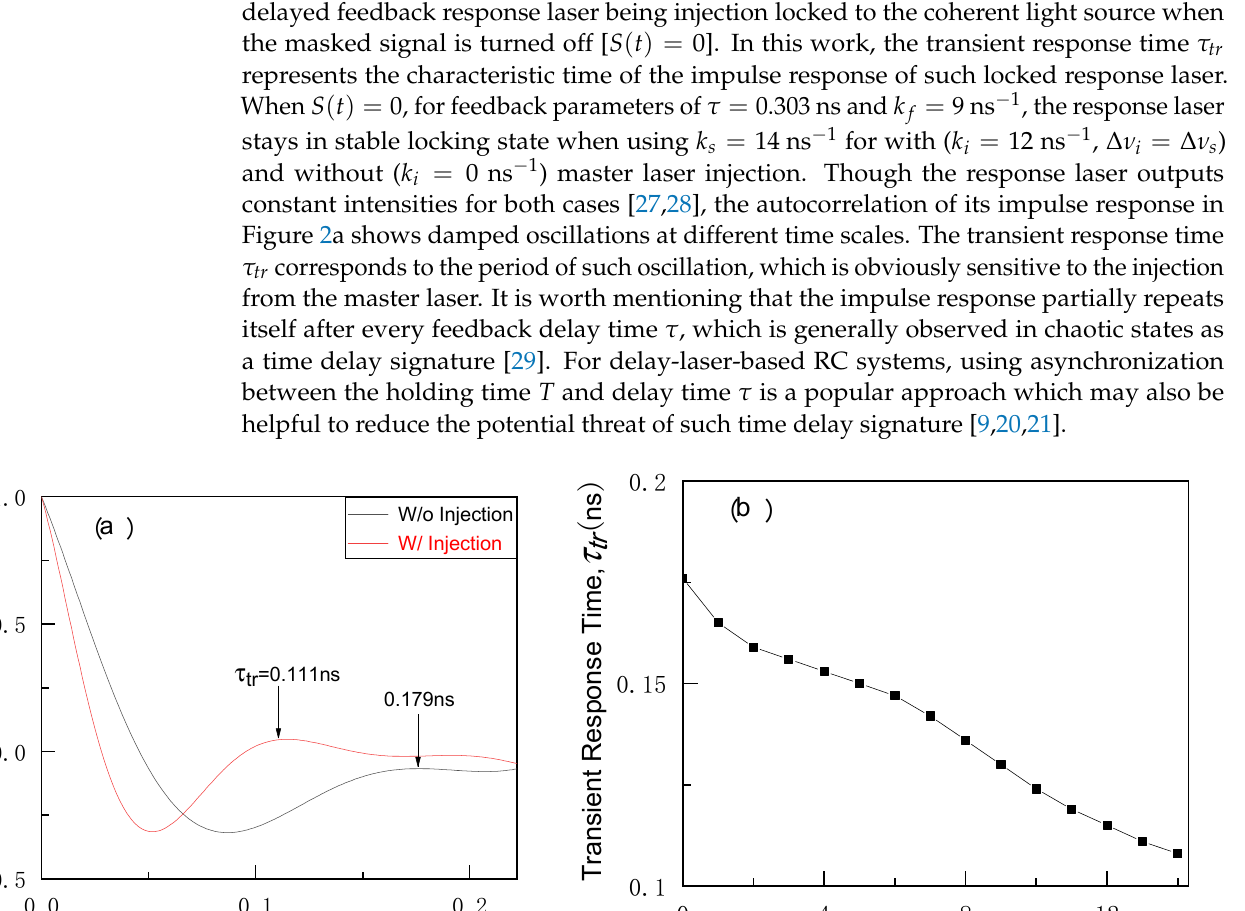
= 12 ns (cid:2879)(cid:2869) , ∆𝜈 = (cid:3036) (cid:3036) as a function (cid:3047)(cid:3045)